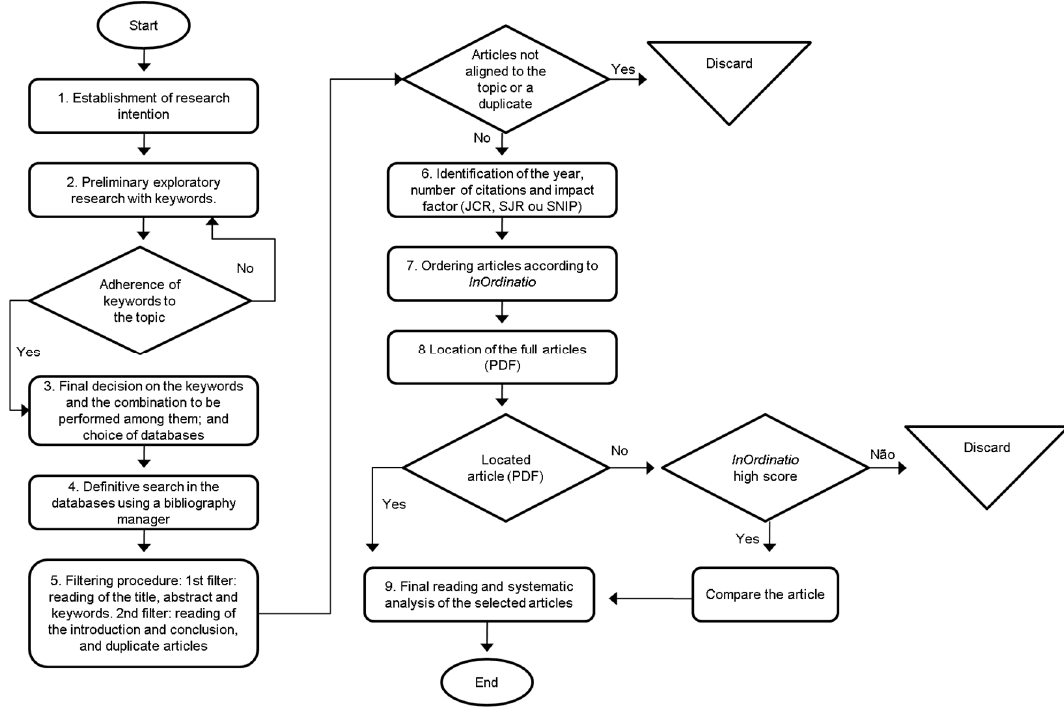
Figure 1. Application Steps of the Methodi Ordinatio methodology (Source: Adapted [32].).